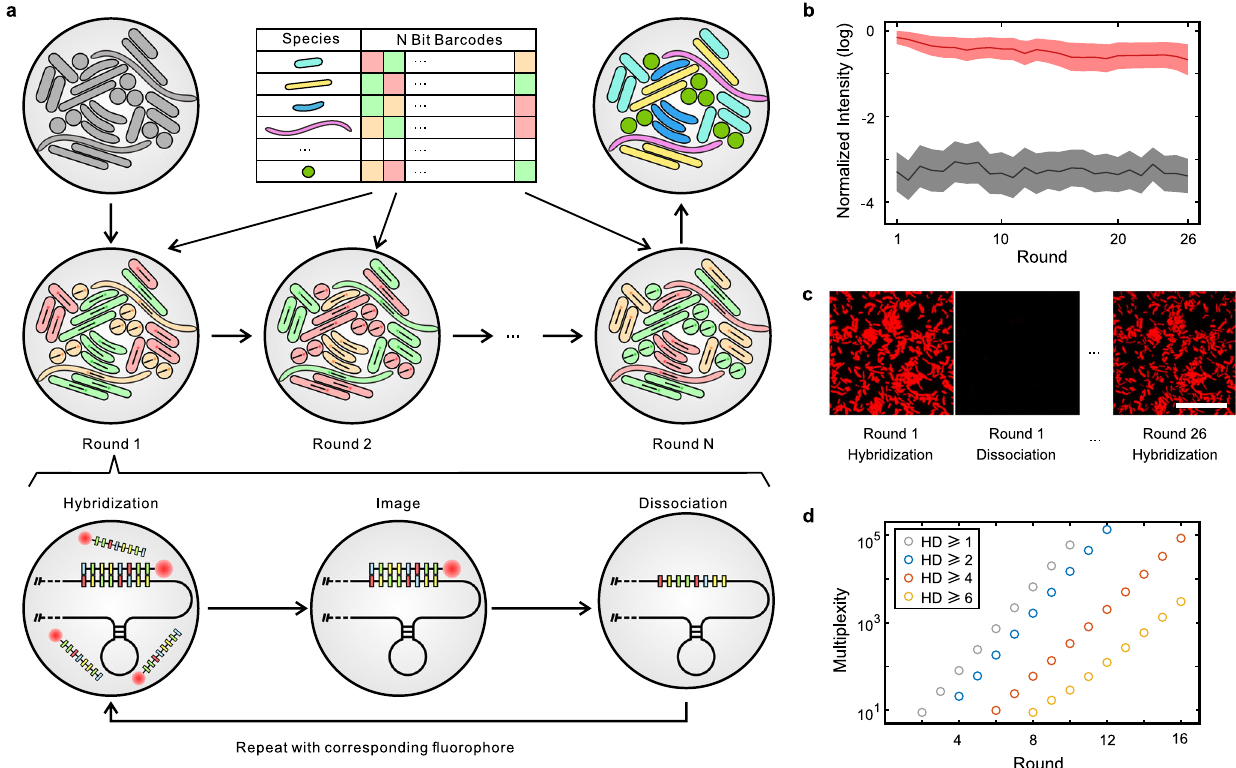
Fig. 1 | SEER-FISH allows superior multiplexity in spatial pro fi ling of micro- biomes.a Designof SEER-FISH.Eachbacterialtaxonisencoded byanF-colorN-bit barcode. The spatial distribution of the microbial community can be obtained through R rounds of FISH. Each round of SEER-FISH includes probe hybridization, imaging, and probe dissociation (see Multi-round FISH imaging in Methods, Sup- plementary Fig. 1a). b , c Fluorescence intensity over 26 rounds ofSEER-FISH. Lines indicate the mean fl uorescence intensity (log-transformed and normalized by the